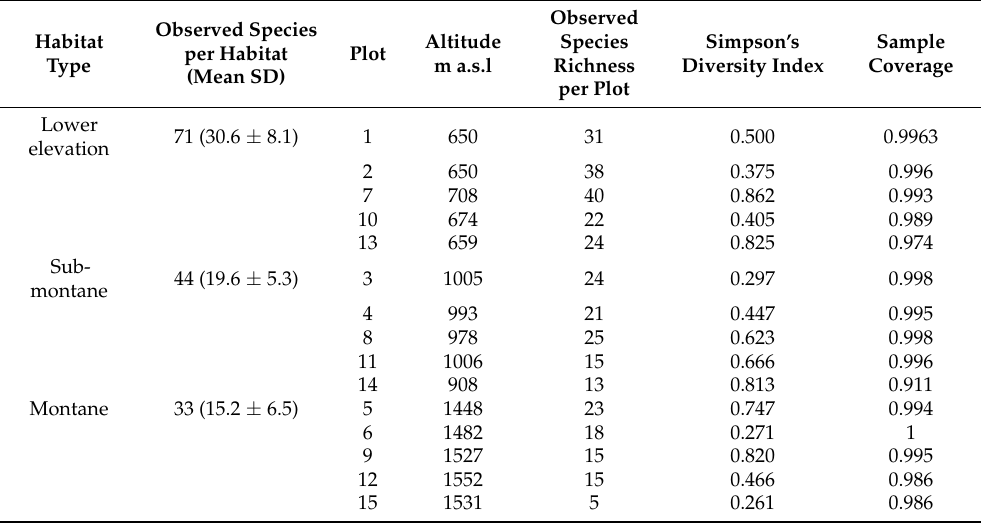
Table 3. Observed number of species (per habitat and plots), Simpson’s diversity index, and sample coverage for each sampling plot in the three habitat types (lower elevation, sub-montane, and montane